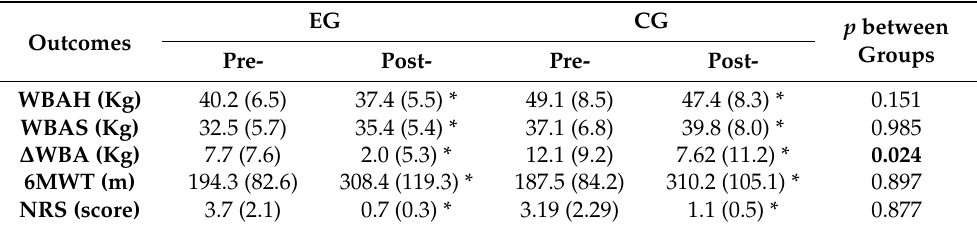
Table 3. Outcomes differences between groups and in the time.